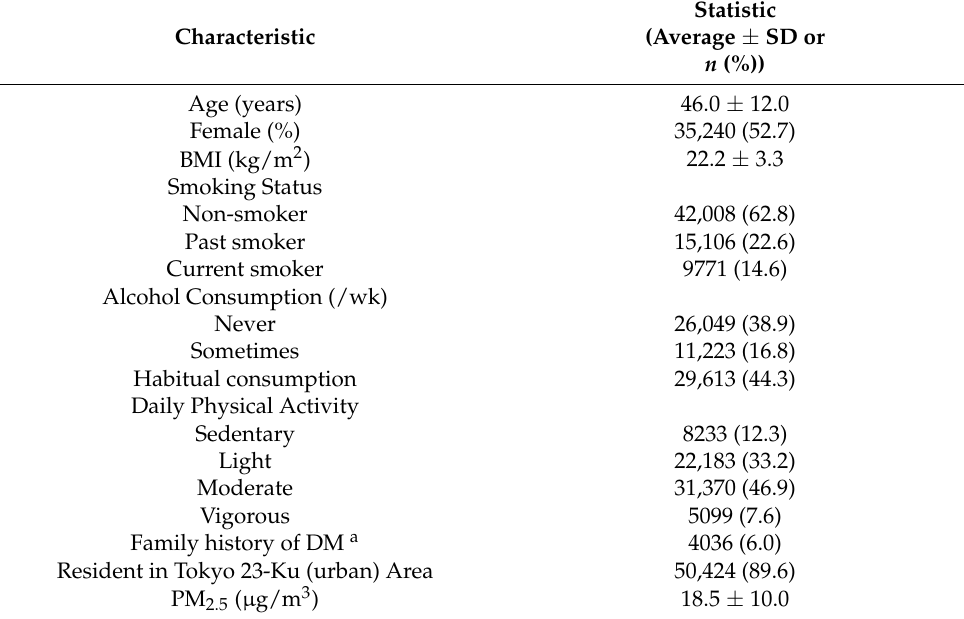
Table 1. Characteristics of the patients at baseline ( N =